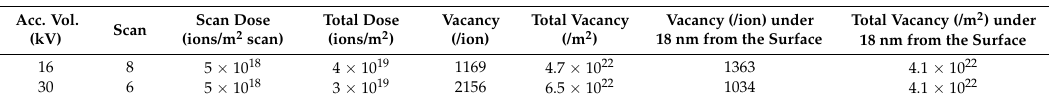
Figure 5. Vacancy distributions of GaSb irradiated with a Ga ion beam as a function of distance from the surface, calculated using SRIM simulations [37] (re-arranged in Figure 1a). Accelerating voltages were ( a ) 16 kV and ( b ) 30 kV. The gray hatched regions indicate the region 18 nm below the surface. Table 3. Comparison of ion beam conditions and point defects calculated by SRIM simulations [37] on similar structure formation of GaSb in Figure